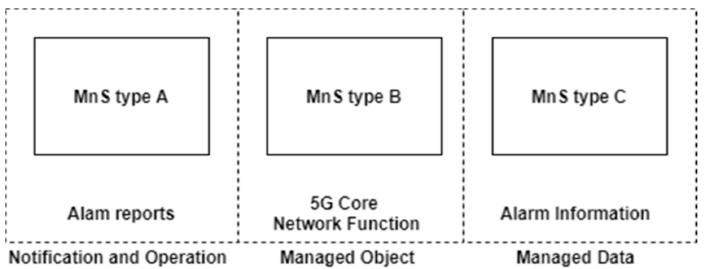
Figure 2. Management Service with MnS types A, B and C for 5G Network Function